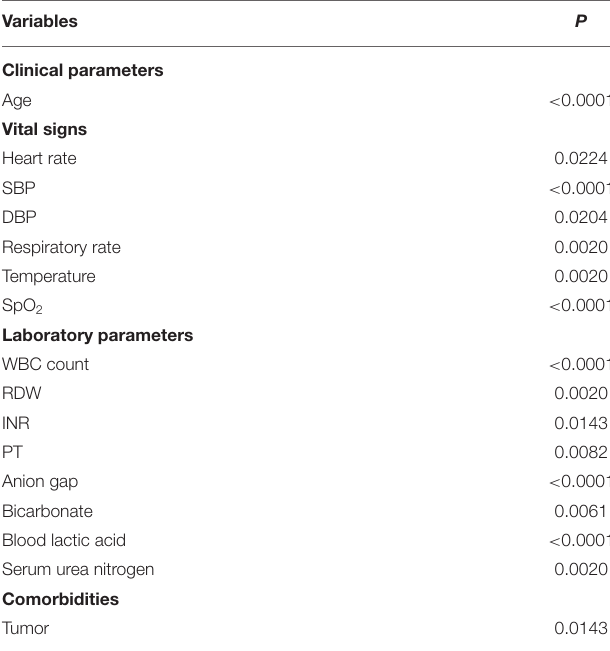
Frontiers in Cardiovascular Medicine |